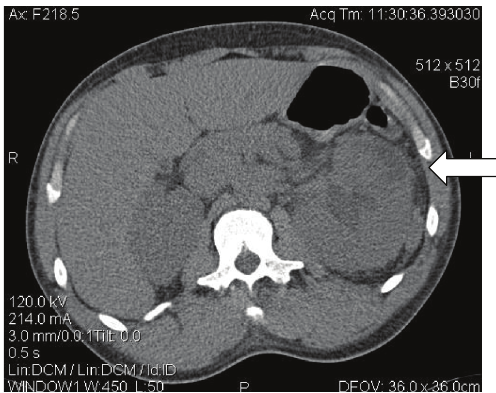
F 2: Enlarged le kidney with a ventral superior hypodensity concerning for a subcapsular �uid